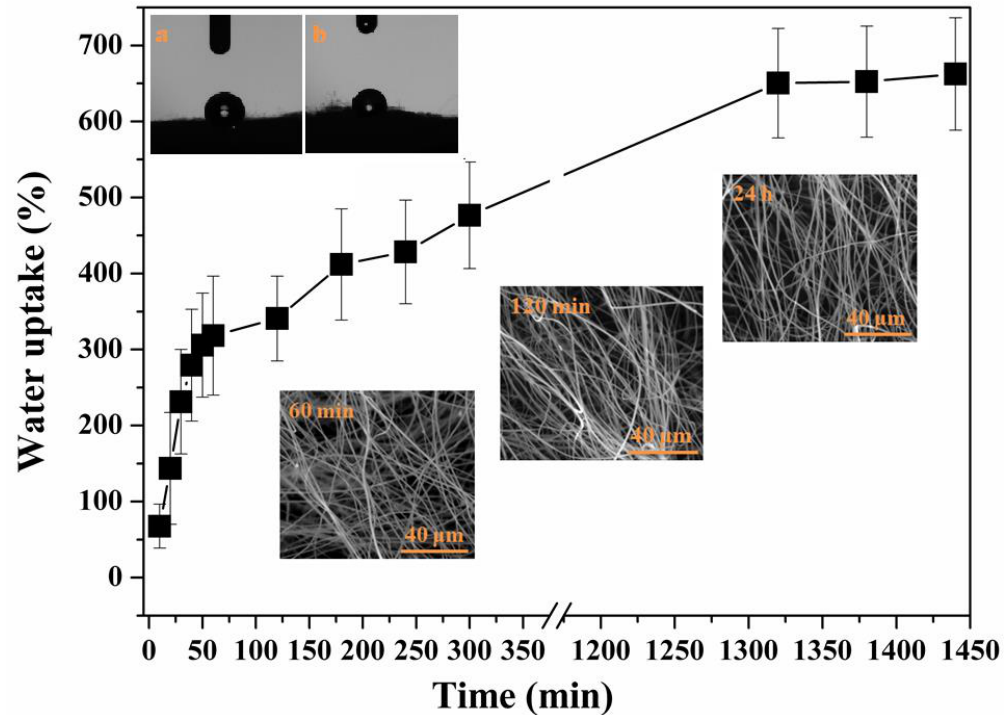
Figure 3. Water uptake capacity of DS-1 fibers, and SEM images of the samples after swelling periods of 60 min, 120 min and 24 h, respectively. In the left corner up insets, images from the contact angle experiments on the sample before swelling ( a ) and after swelling study ( b ), are given.